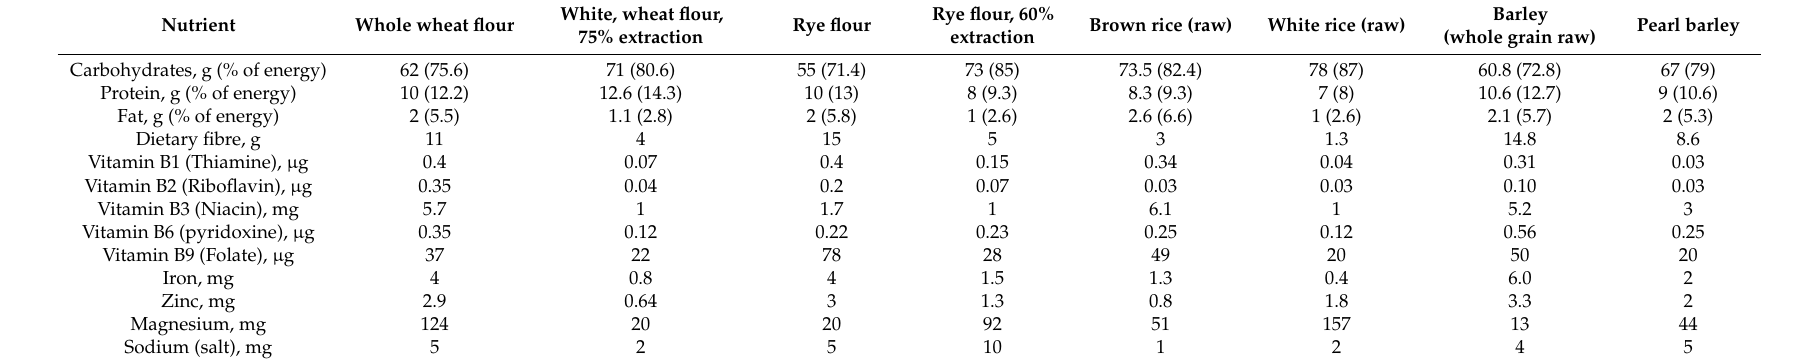
Table 4. Nutritional compositions of different whole grain and refined grains, per 100 g